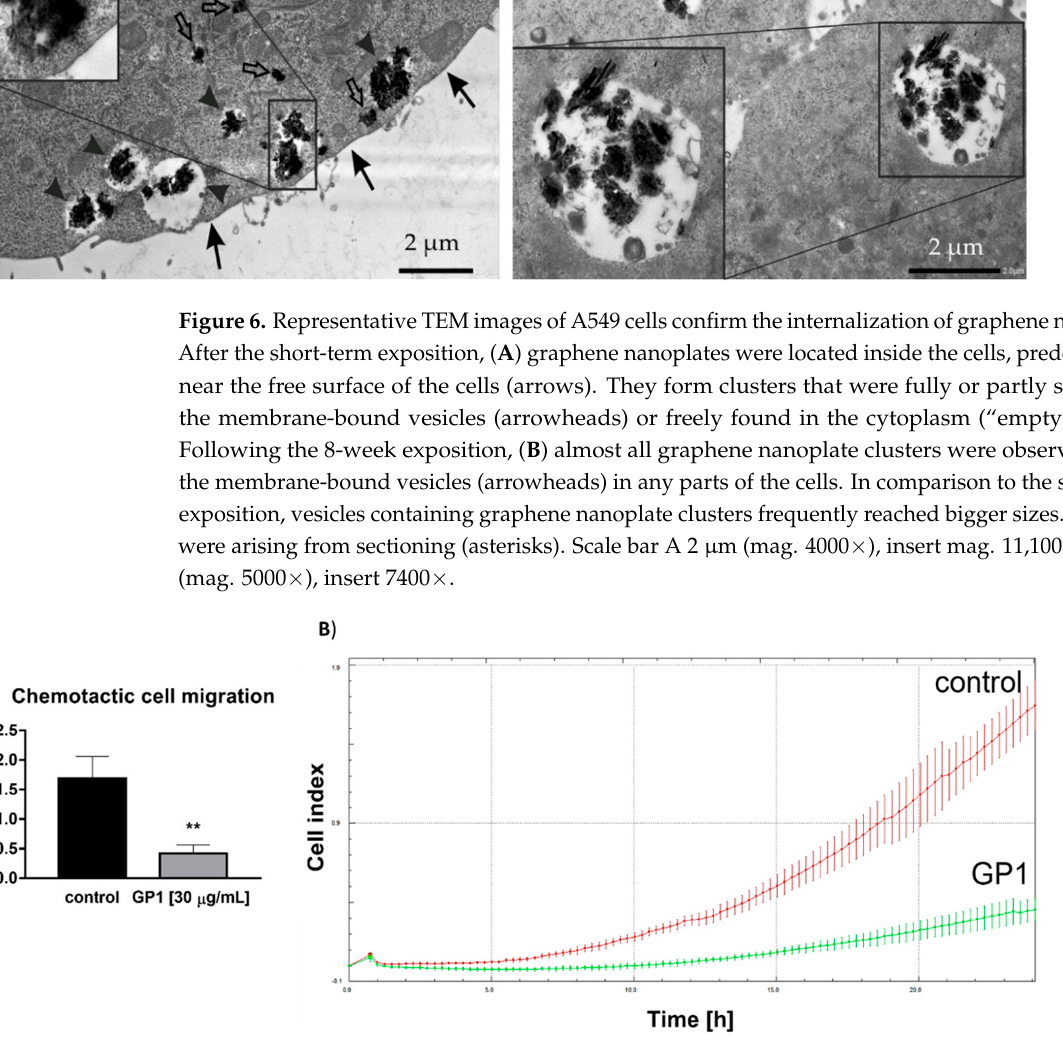
Figure 6. Representative TEM images of A549 cells confirm the internalization of graphene nano- plates. After the short-term exposition, ( A ) graphene nanoplates were located inside the cells, pre- dominantly near the free surface of the cells (arrows). They form clusters that were fully or partly situated in the membrane-bound vesicles (arrowheads) or freely found in the cytoplasm (“empty” arrows). Following the 8-week exposition, ( B ) almost all graphene nanoplate clusters were observed inside the membrane-bound vesicles (arrowheads) in any parts of the cells. In comparison to the short-term exposition, vesicles containing graphene nanoplate clusters frequently reached bigger sizes. Smudges were arising from sectioning (asterisks). Scale bar A 2 µm (mag. 4000×), insert mag. 11,100×; B 2 µm (mag. 5000×), insert 7400×.